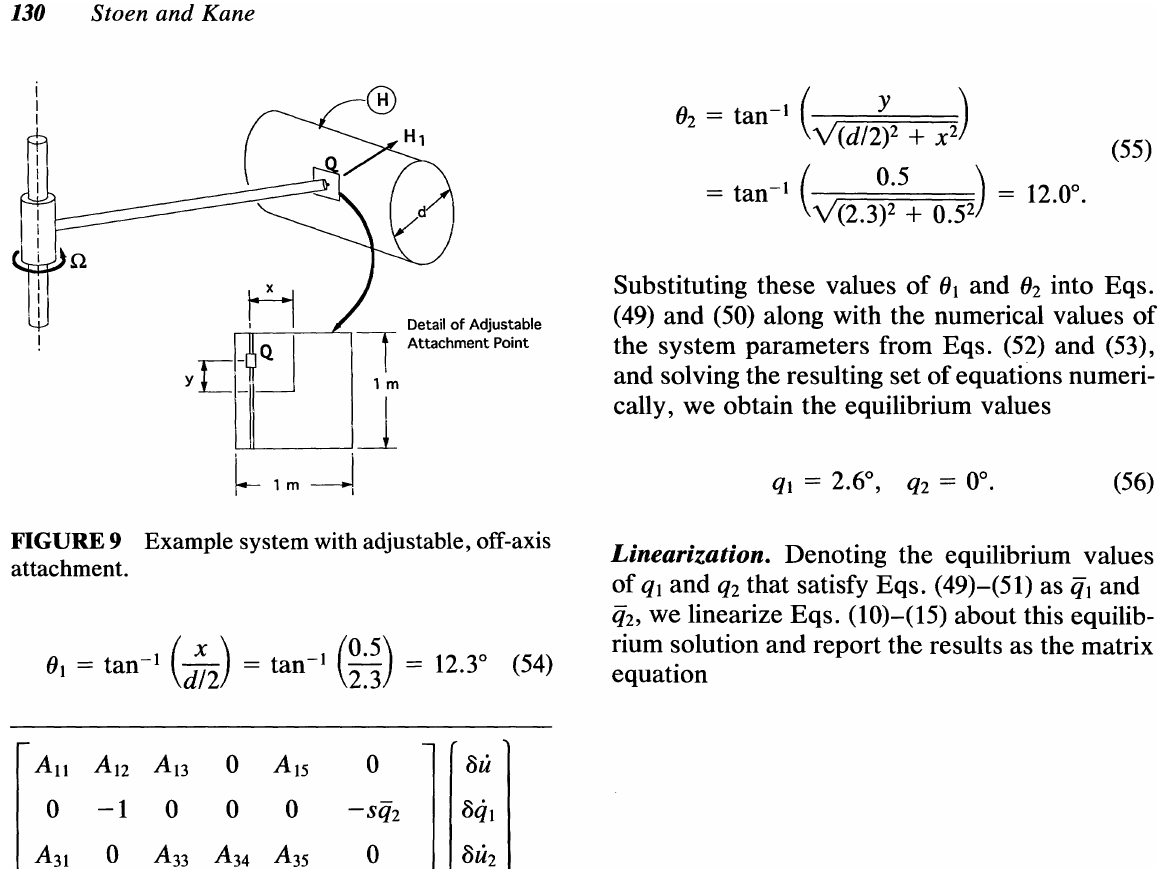
FIGURE 9 Example system with adjustable, off-axis